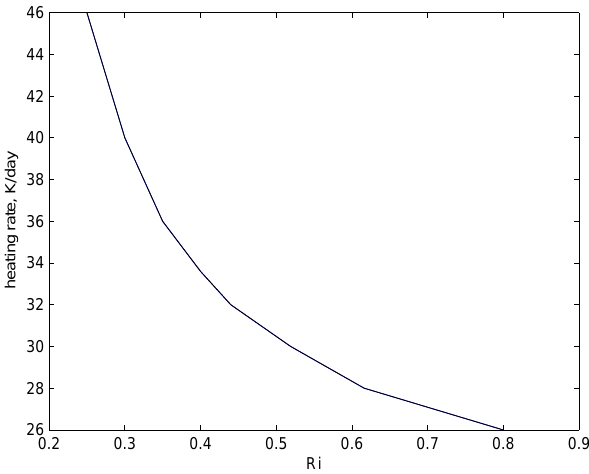
Fig. 8. The [O] height profile shown by the lowest curve calculated with the eddy diffusion coefficient shown in Fig. 5. The profile shown by the middle and upper curves corresponds to calculations with S 3 increased by a factor of 2 and 4,